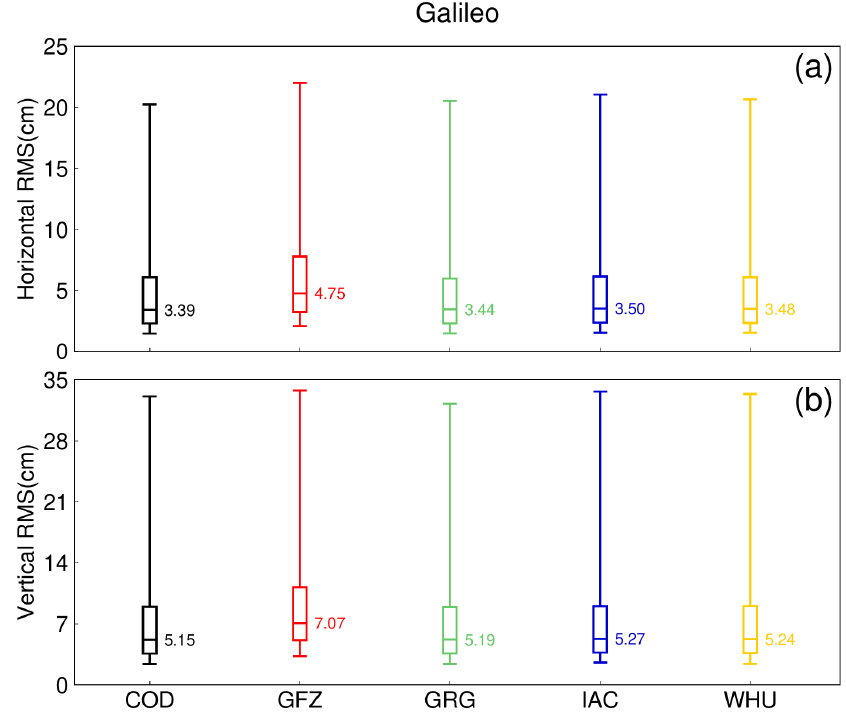
Figure 16. Distribution of the RMS (( a , b ) for the horizontal and vertical component, respectively) of the Galileo kinematic PPP solutions with five types of precise products for the 143 MGEX tracking stations in September 2022. ( a ) Horizontal component, ( b ) Vertical component.